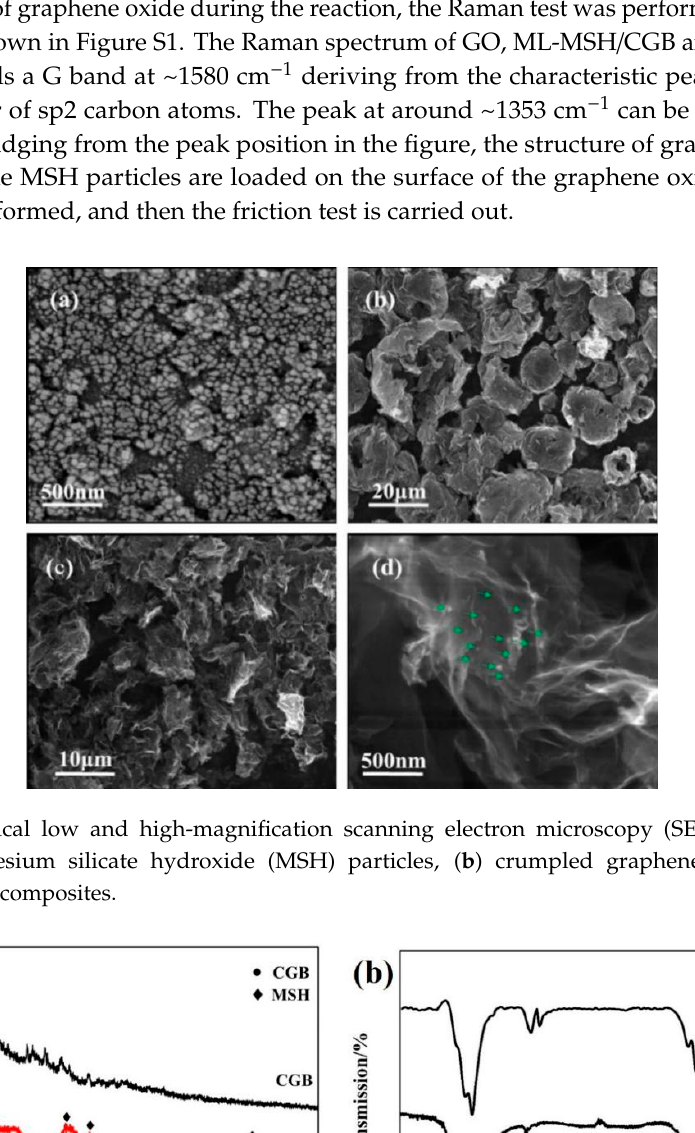
Figure 2. ( a ) X-ray di ff raction (XRD) spectrum of CGB, MSH and modified lipophilic composites (ML)-MSH / CGB, ( b ) Fourier transform infrared spectroscopy (FTIR) patterns of MSH / CGB and ML-MSH /